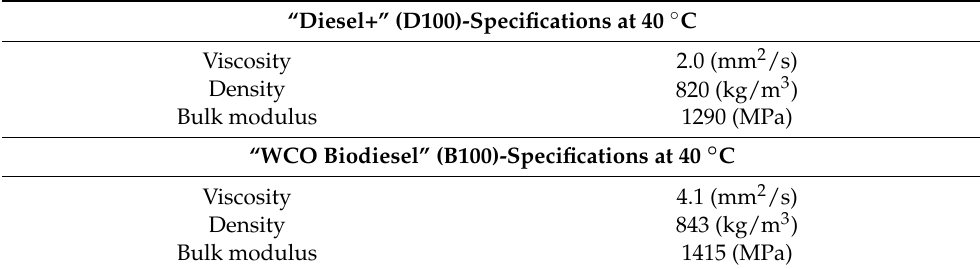
Table 3 resumes their mechanical specifications. Table 3. Specifications of used pure